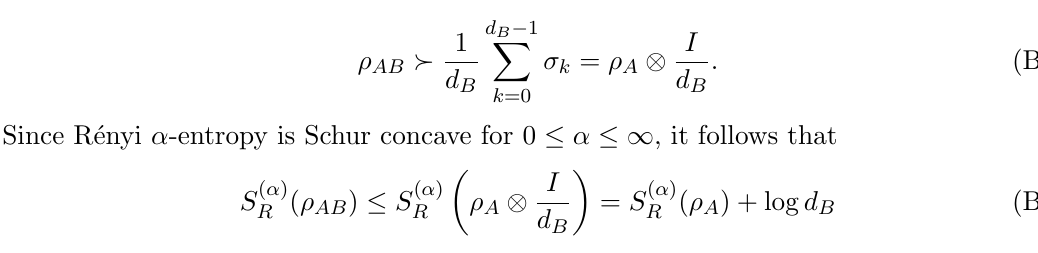
; note that (cid:27) = (cid:27) . Then all (cid:27) have 0 B k